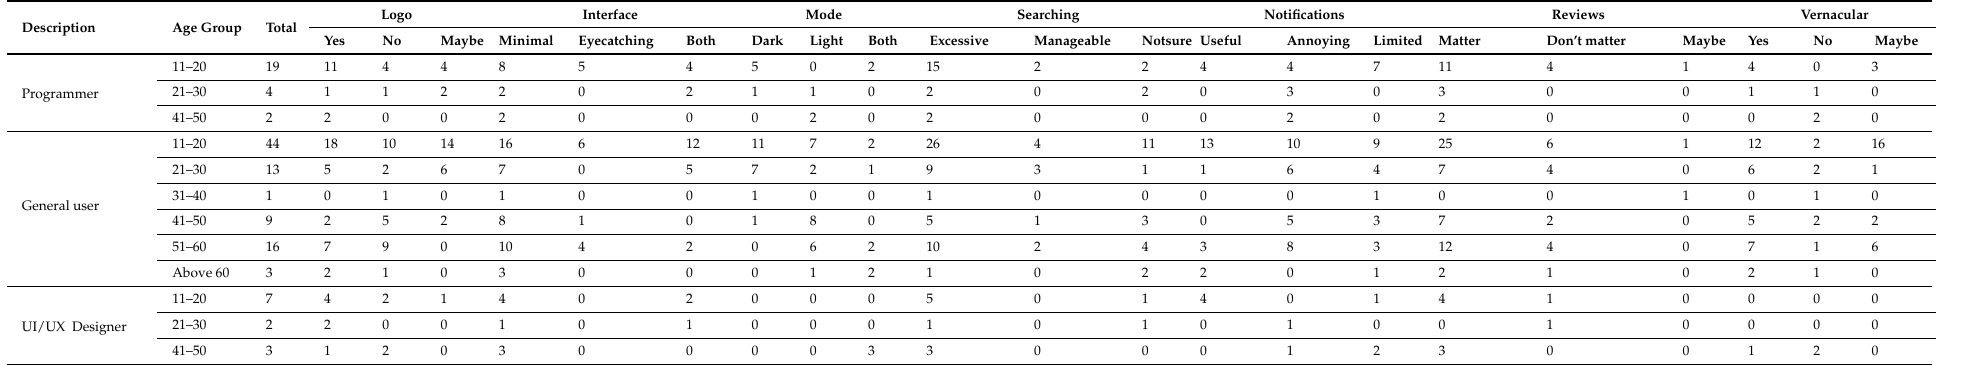
Table 3. Parametric perception data from survey: Males.